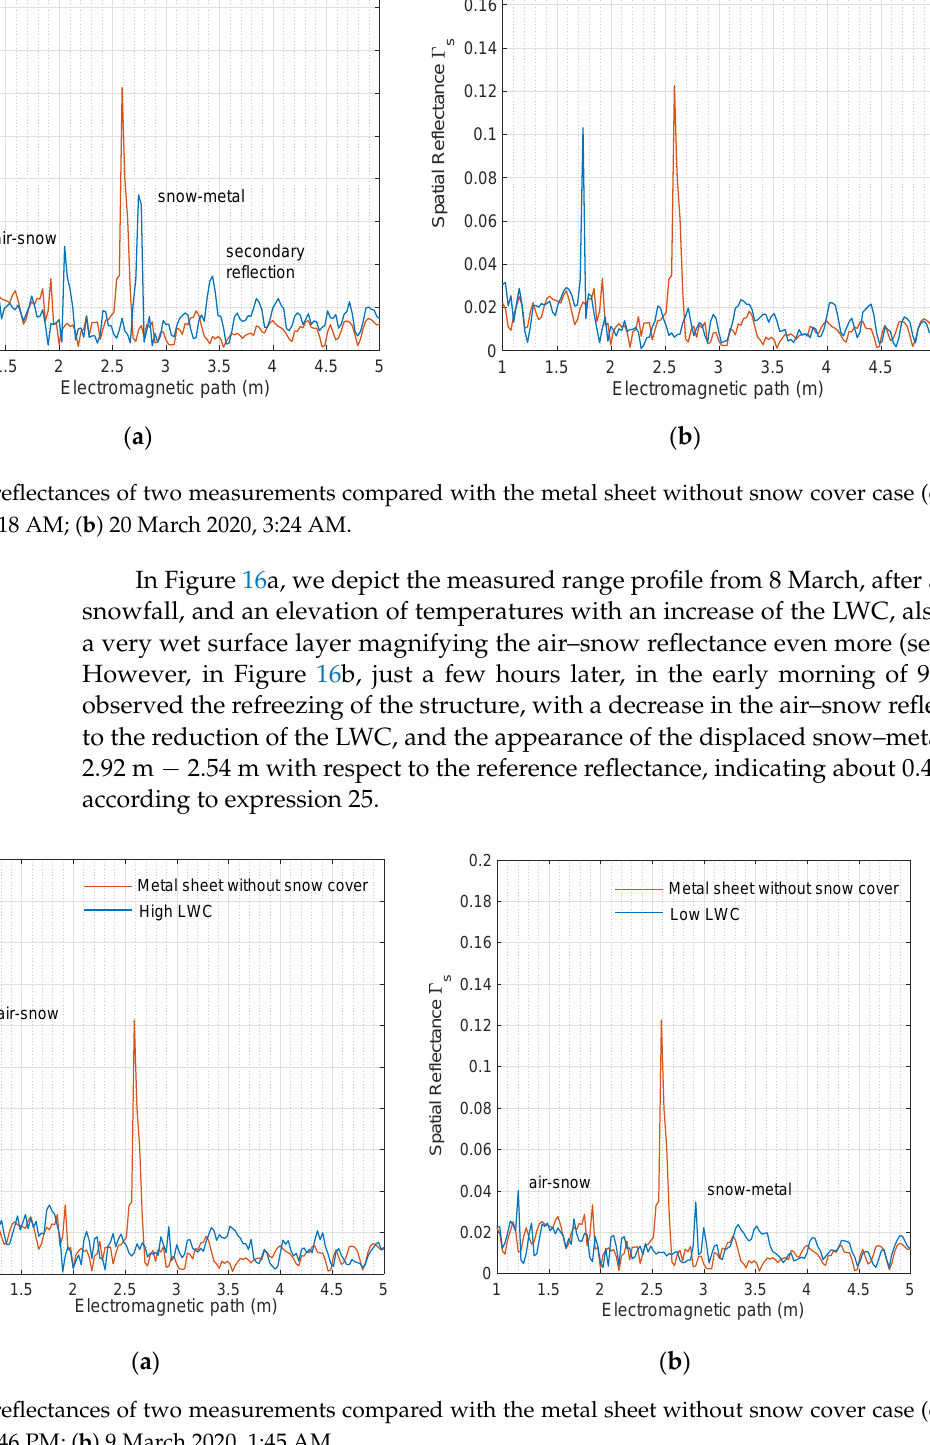
( b ) Figure 17. Spatial reflectance of two measurements compared with the metal sheet without snow cover case (orange): ( a ) 20 January 2020, 7:02 AM; ( b ) 1 April 2020, 3:53 PM. Figure 18 shows a summary of the conditions under which the experiment was de- veloped. The upper graph shows the temperatures recorded throughout the measurement period. This information is important since the snowpack is exposed to periods with tem- peratures higher than 0 °C, even at night. The central chart represents an image of the space-time profiles recorded over the measurement period. In this image, it is possible to appreciate the time intervals in which the reflections of the air–snow interface or the snow–metal interface predominate.